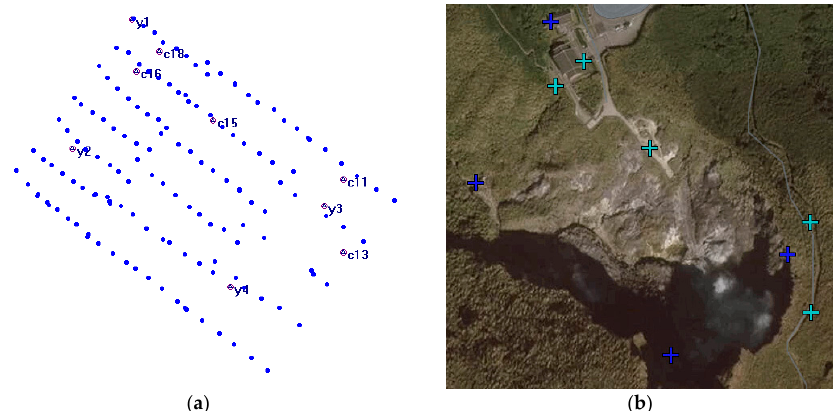
Figure 9. Ground control points (GCPs) and Check Points of GNSS-supported position and orientation of thermal images. GCPs: y1, y2, y3, y4 by stereo measurements from historic aerial stereo images; Check Points: 11, 13, 15, 16, 18 by the real-time kinematic (RTK) GPS Surveying method. ( a ) Locations of control points, check points and image centers, ( b ) Locations of control points, check points overlaied with Google